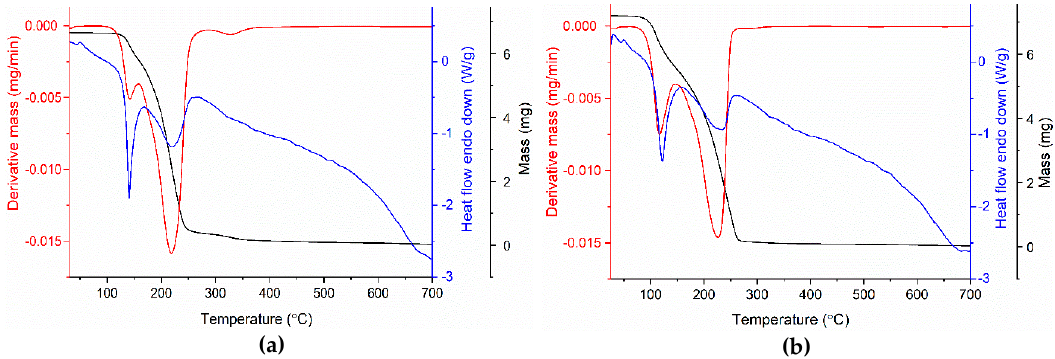
Figure 5. Thermo-analytical curves of HEEA- p ABA ( a ) and HDEEA- p ABA ( b ).